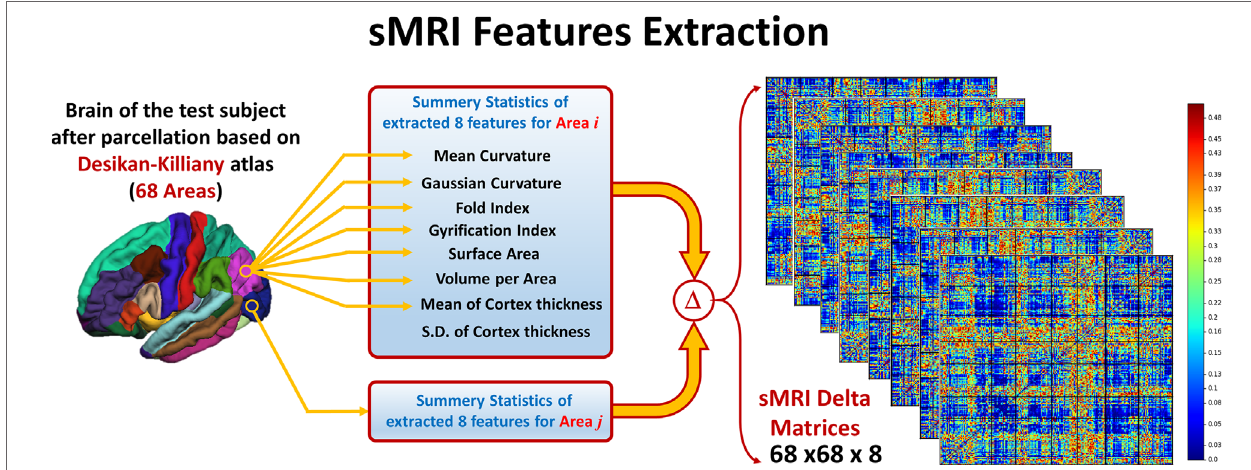
FIGURE 2 | Eight features are extracted from the parcellated volume; summary statistics are calculated for each feature at each DK atlas area. Then, Delta matrix for each subject is calculated by subtracting the feature values between each couple of areas. The output feature matrix is 68 × 68 ×